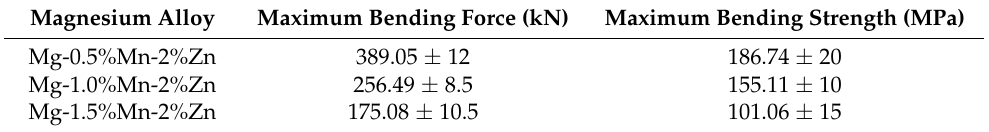
Table 2. Bending strength of Mg-Mn-Zn